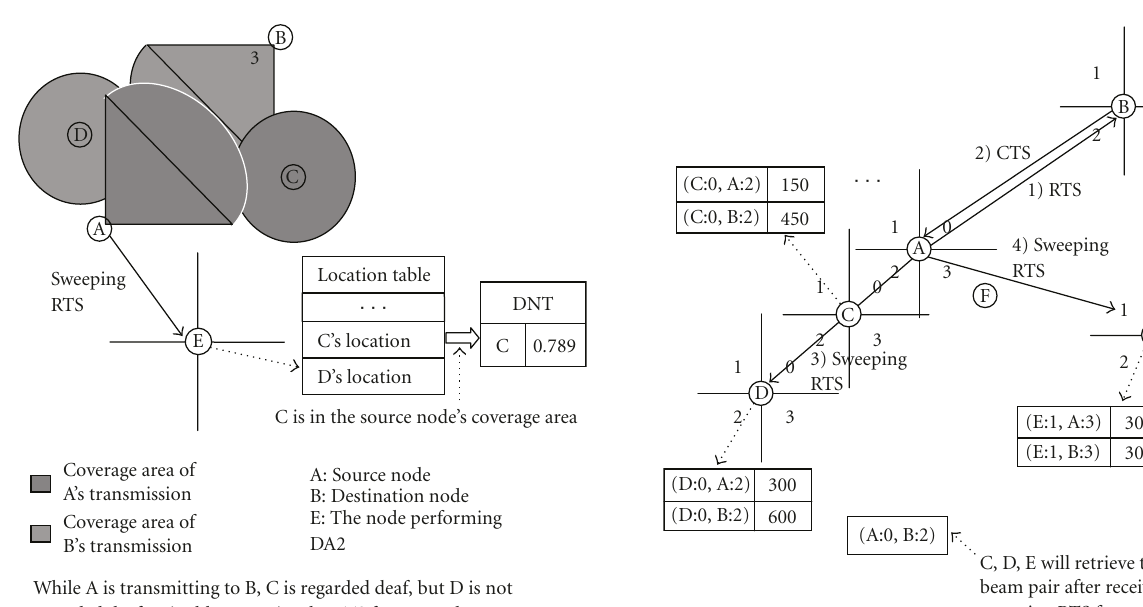
Figure 13: Illustration of the DA2 mechanism.